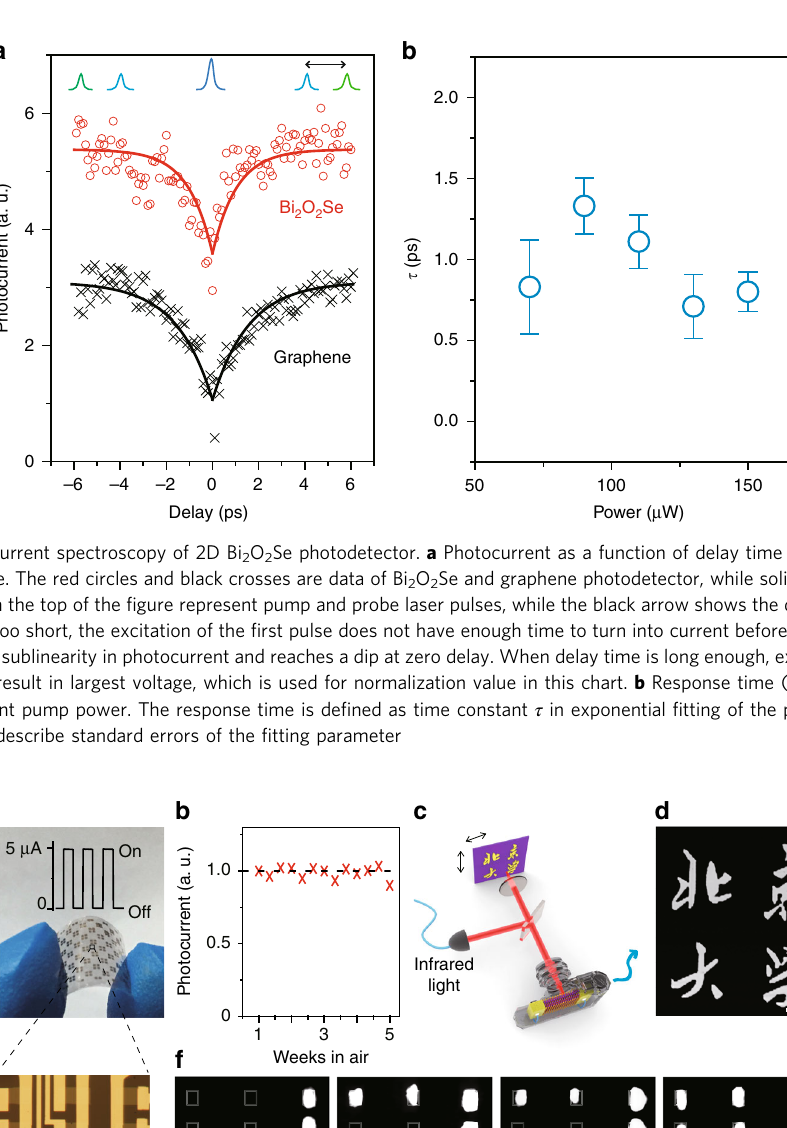
2D fl exible Bi 2 O 2 Se photodetector arrays . To better understand the potential of 2D Bi 2 O 2 Se in IR sensing applications, we designed and fabricated fl exible 2D Bi 2 O 2 Se photodetectors and their arrays on mica through a facile process (Fig. 4a, e and Supplementary note 3) and tested them in ambient air. The Bi 2 O 2 Se photodetector arrays show consistent photoresponse when bending the substrate with strain of up to 1% (inset of